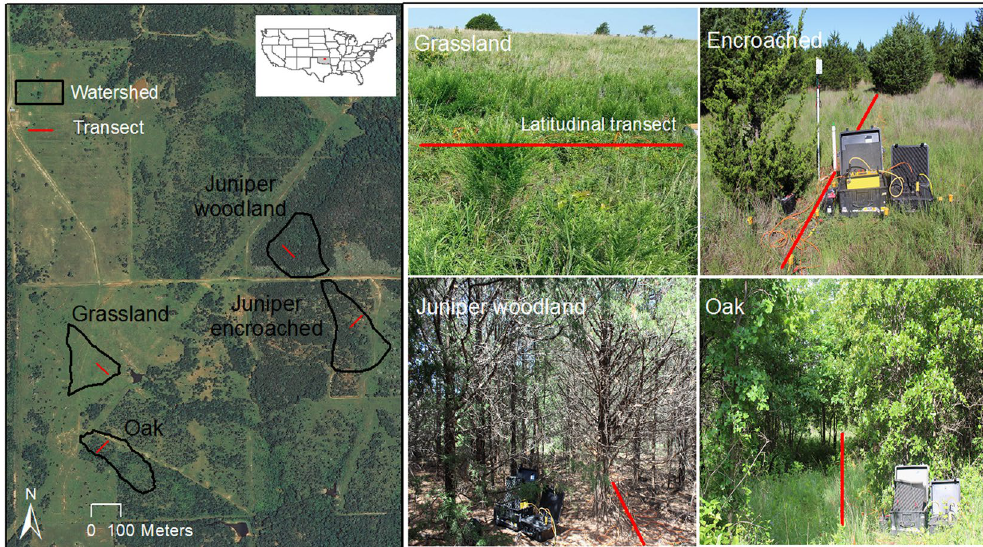
Figure 1. Experiment site located in the south-central Great Plains at the Oklahoma State University Cross Timber Range Research Station showing the grassland, the juniper-encroached site with SuperSting 8-channel resistivity meter and switchbox and battery, the juniper woodland and oak forest. The data used in the figure were obtained from Data Gateway (https://datagateway.nrcs.usda.gov/) and the map was created using ArcGIS 10.3.1 (Esri. Inc). The 2013 orthoimagery was photographed by USDA-FSA-APFO. Photos of different vegetation cover types were taken by Dr. Acharya and are true to